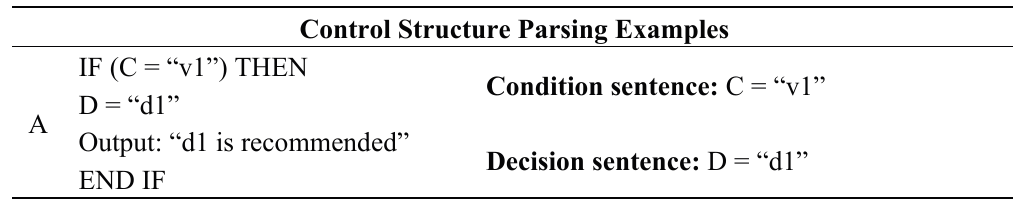
Table 1. Control Structure Parsing